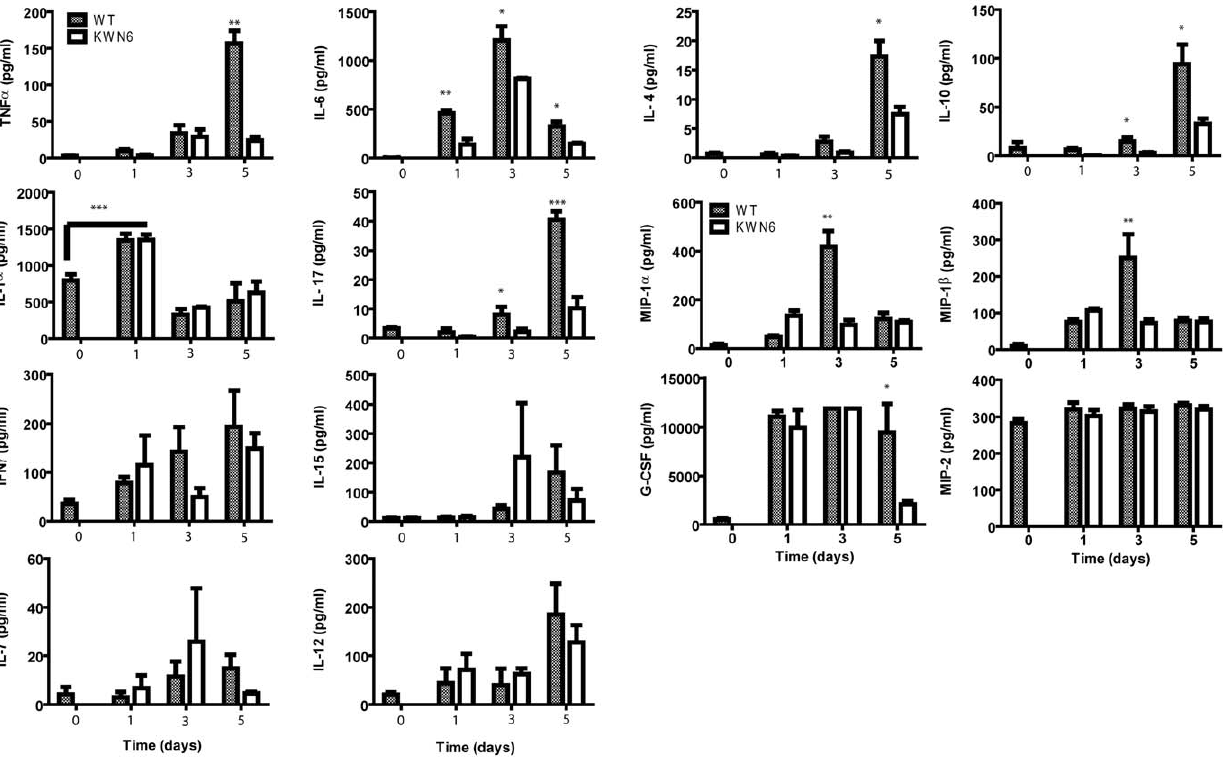
Figure 5. Effects of Dur1,2p expression in C.albicans on host serum cytokines and chemokines. Serum levels of the indicated proteins were assessed at 1 to 5 days PI for mice infected iv with WT (gray bars) or KWN6 (open bars). Values at time 0 are mean values determined for sera from 5 control mice, and other data are mean 6 standard deviation for 3 mice at each time point. * = p , 0.05; ** = p , 0.01; *** =p , 0.001. doi:10.1371/journal.pone.0048475.g005 ment of phagocytes to sites of inflammation [34] were also markedly increased. CCL3 (MIP1 a ) and CCL4 (MIP1 b ) were